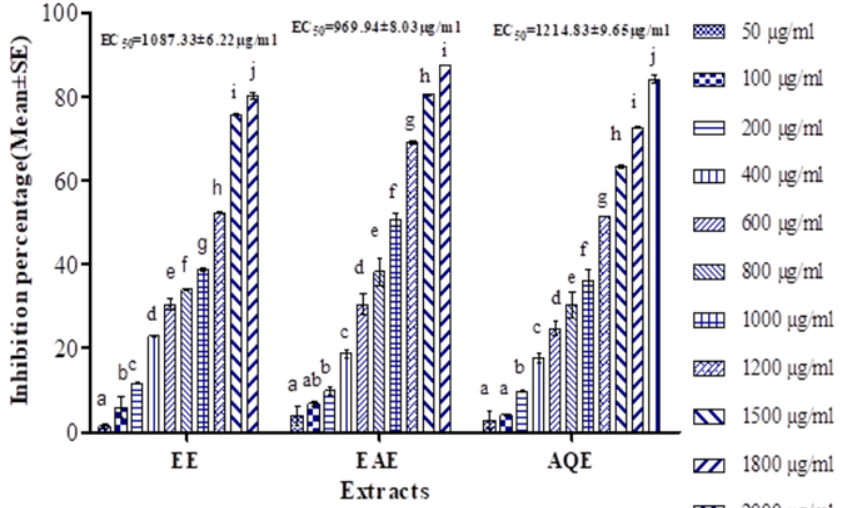
FIGURE 2 - Superoxide anion free radical scavenging potential of N. arbor-tristis L. seed extracts. Different letters indicate the significant differences from each other at P